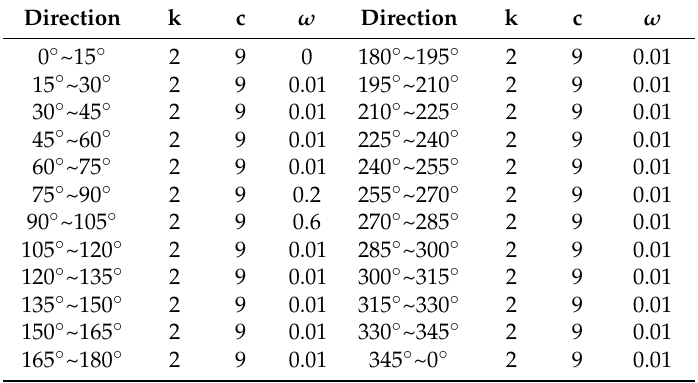
Table 2. Detail of the Weibull distribution wind condition for the wind farm optimization.